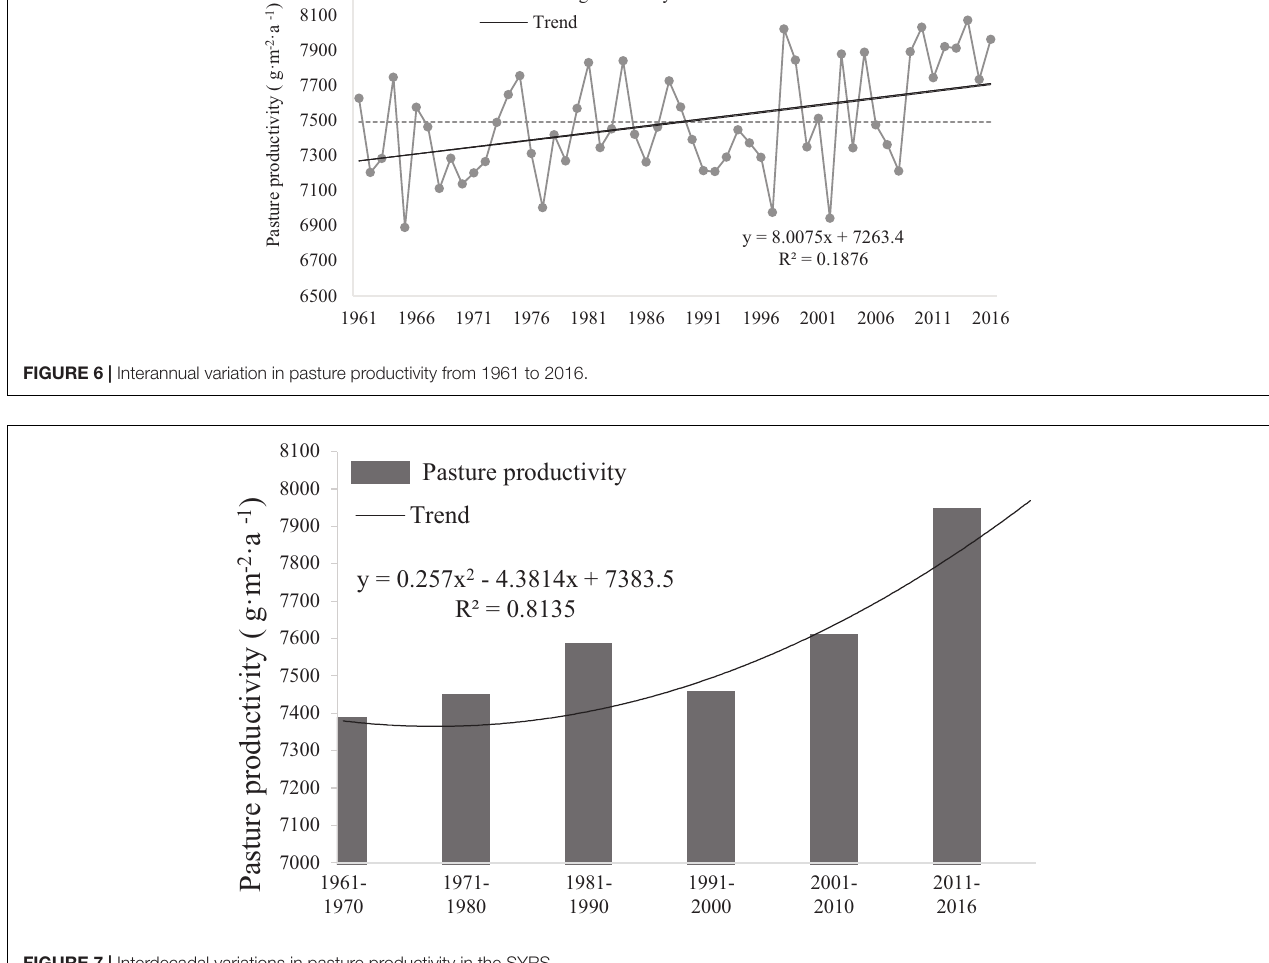
FIGURE 7 | Interdecadal variations in pasture productivity in the SYRS.